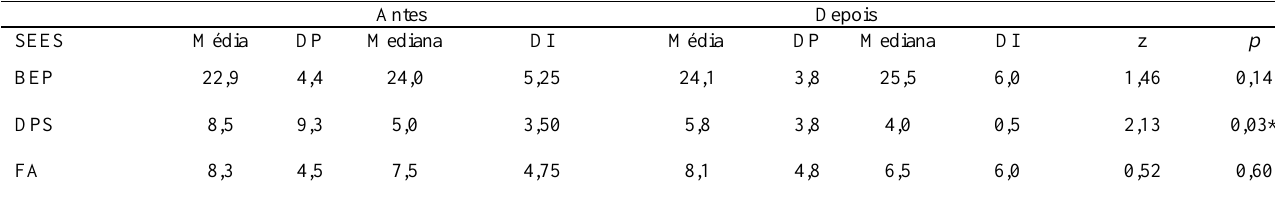
Tabela 2. Média, desvio-padrão, mediana, desvio interquartílico e resultados do teste Wilcoxon para cada subescala da SEES referentes ao exercício realizado em AR